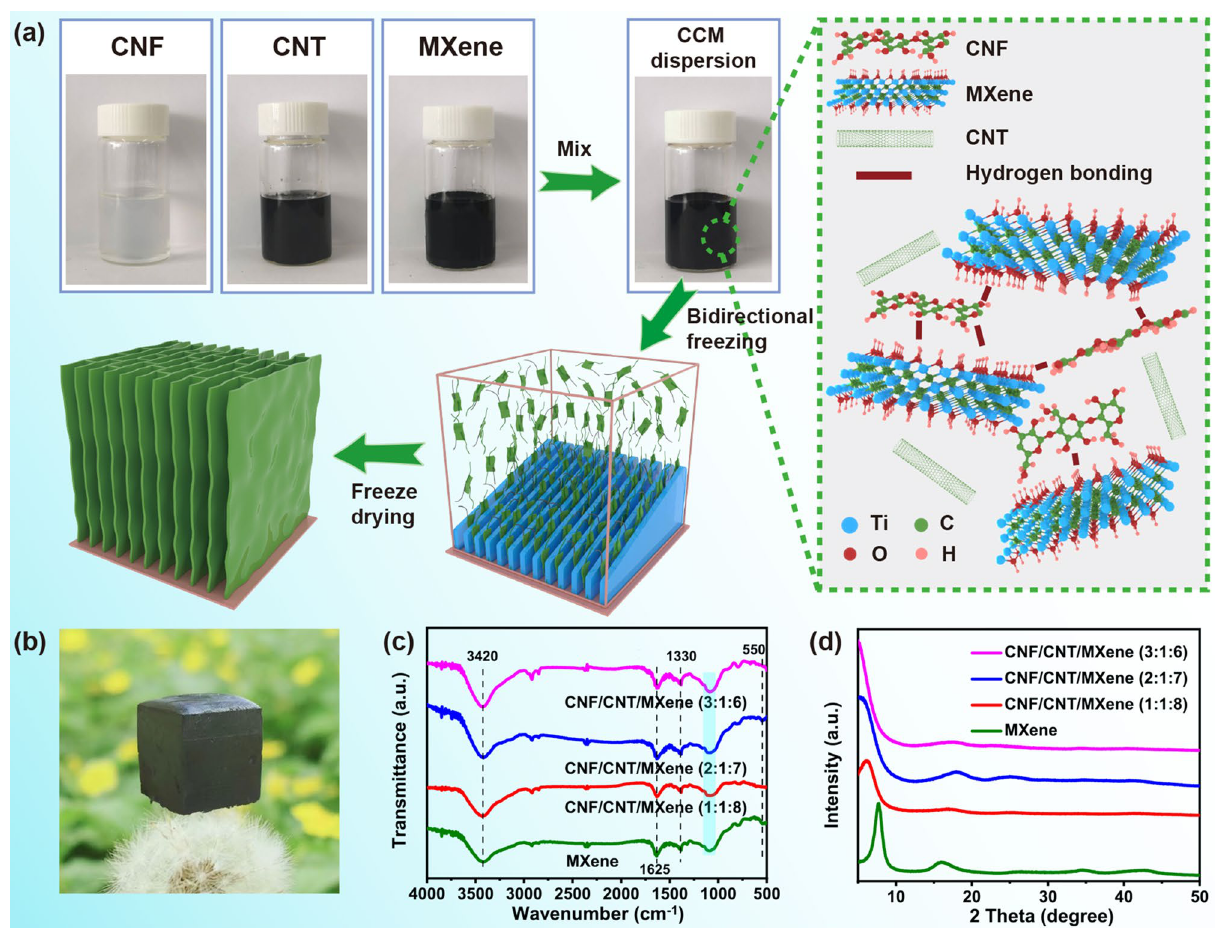
Fig. 1 a Schematic illustration for the fabrication process of CNF/CNT/MXene aerogels. b Photo image of the lightweight CNF/CNT/MXene aerogel on the top of a dandelion. c FTIR and d XRD patterns of MXene and different CNF/CNT/MXene